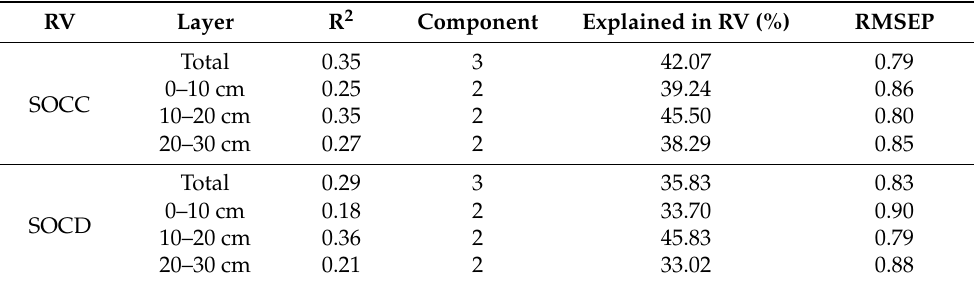
Table 2. Summary of the best supported partial least squares regression (PLSR) models for forest traits and SOC parameters in different soil layers. RV, response variables; SOCC, soil organic carbon concentration; SOCD, soil organic carbon density; RMSEP, root mean squared error of prediction.